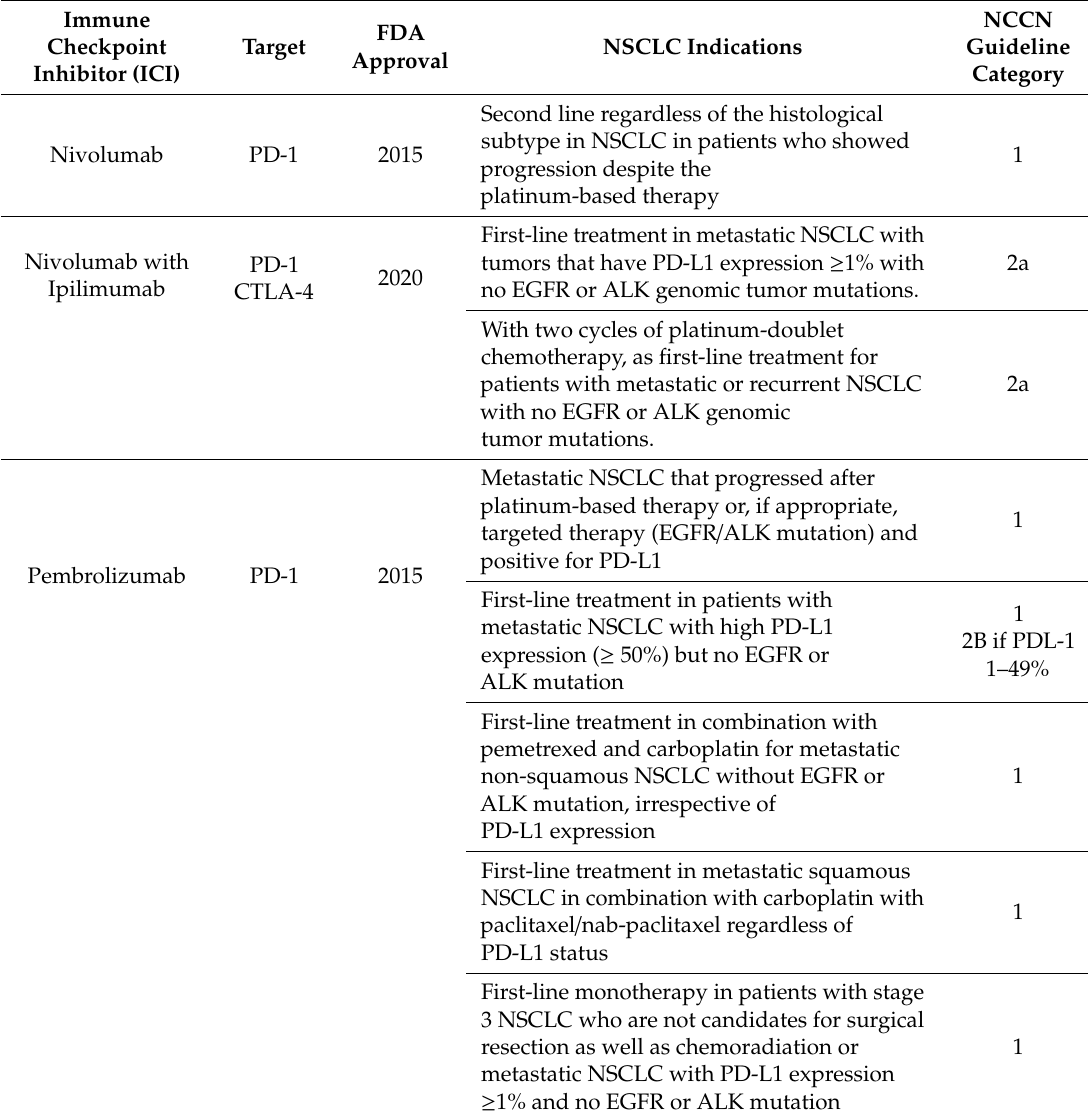
Table 1. Indications (with the level of evidence) for specific ICIs in the NSCLC treatment, according to the Food and Drug Administration (FDA) and National Comprehensive Cancer Network (NCCN) recommendations